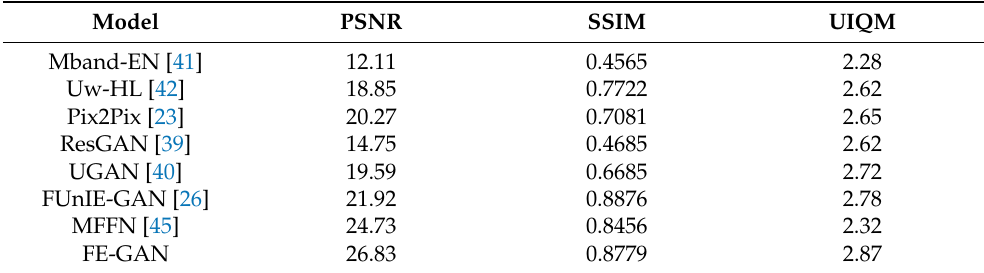
Table 1. Quantitative comparison results with the state-of-the-art methods in the EUVP dataset. Model PSNR SSIM